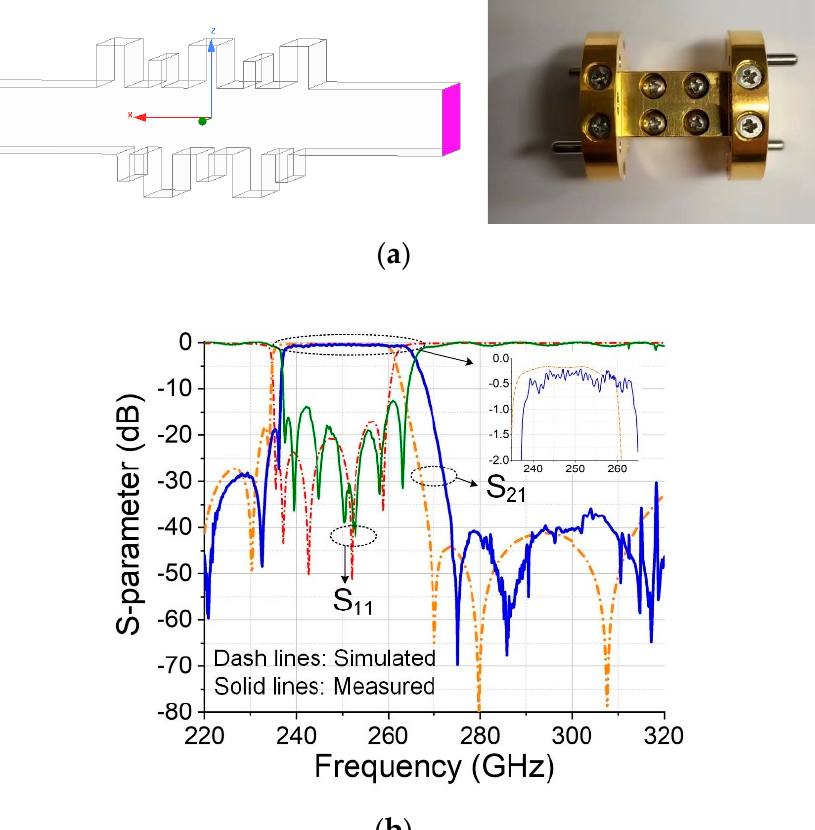
Figure 8. ( a ) Design and fabricated photo of the proposed THz BPF, and ( b ) its simulation and measurement results.